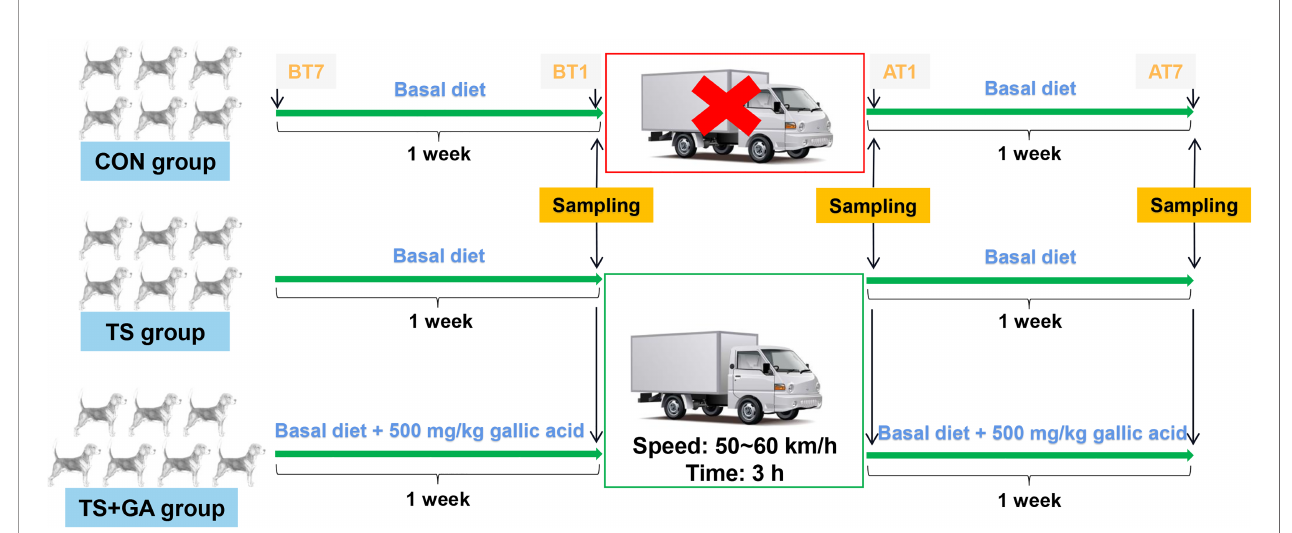
FIGURE 1 | Schematic representation of the study design. BT7, the 7th day before transportation; BT1, the 1st day before transportation; AT1, the 1st day after transportation; AT7, the 7th day after transportation. The CON group was fed basal diet with no transportation (n = 6), the TS group was fed basal diet with transportation (n = 6), and the TS+GA group was fed basal diet+500 mg/kg of gallic acid (GA) with transportation (n =